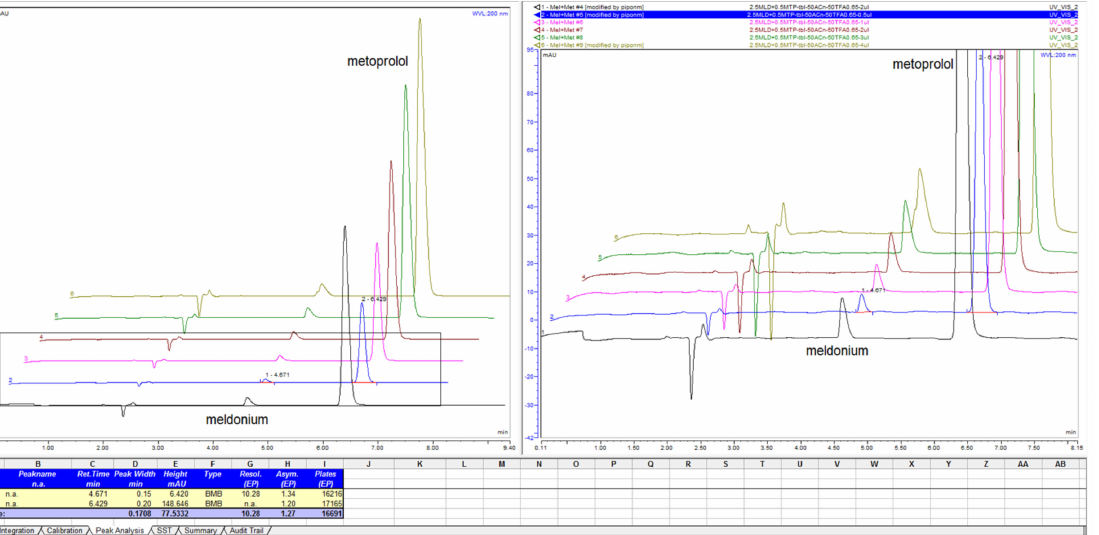
Figure 24. Dionex full-scale overlaid and expanded zoomed Y-axis of overlaid chromatograms for the linearity of the method with Waters Spherisorb CNRP-250 × 4.6 mm and 50%ACN and 50% diluted TFA at 200 nm, with system suitability parameters in the